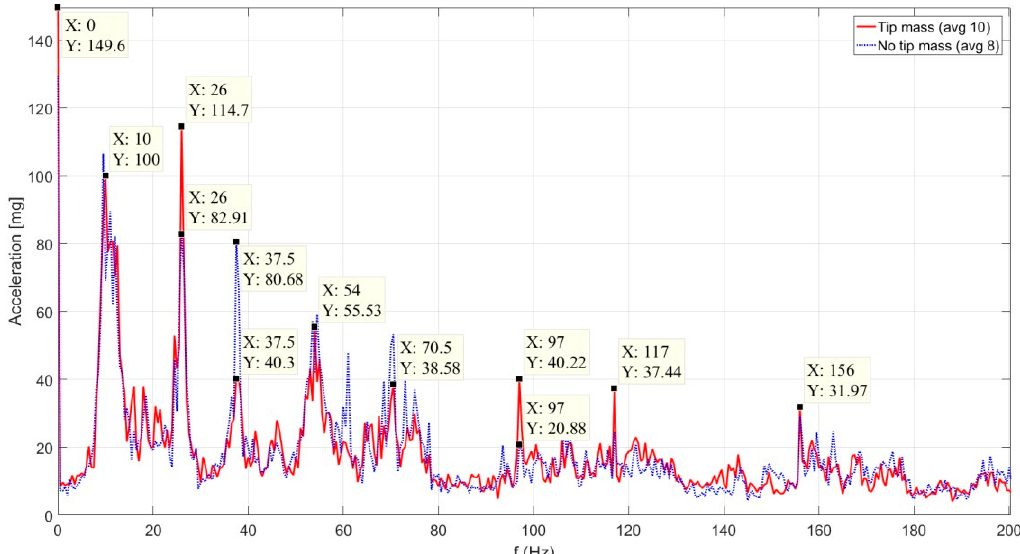
Figure 3. Averaged, single-sided amplitude spectrum of the acceleration on the sidewall of an air-